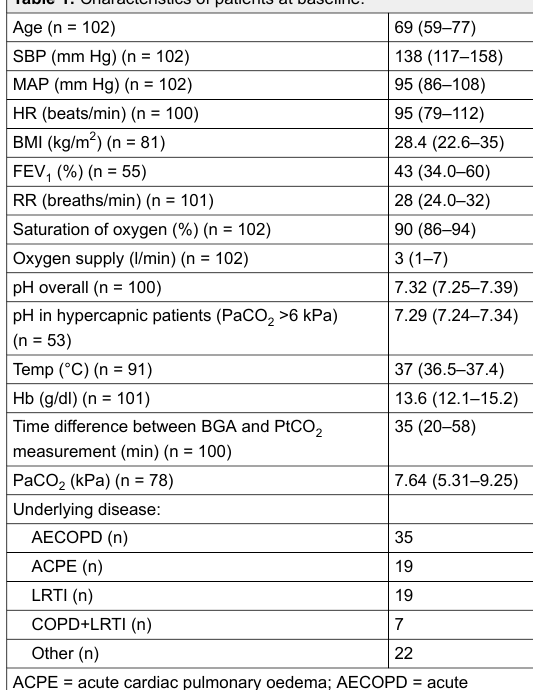
index; COPD = chronic obstructive pulmonary disease; Hb = haemoglobin; HR = heart rate; LRTI = lower respiratory tract infection; MAP = median blood pressure; PaCO 2 = arterial carbon dioxide tension; PtCO 2 = transmembraneous carbon dioxide tension; RR = respiratory rate; SBP = systolic blood pressure; Temp = temperature Values are reported as median with inter-quartile